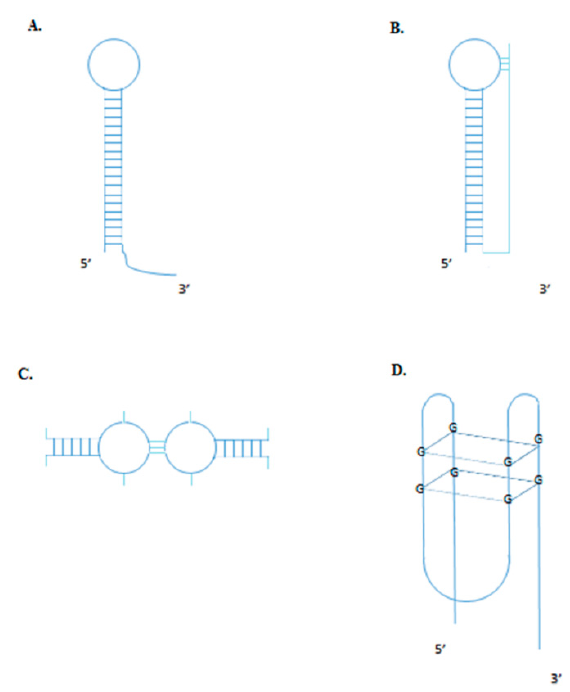
Figure 2. Aptamer secondary structures: ( A ) Hairpin motif; ( B ) Pseudoknot motif; ( C ) “Kissing loops” motif; and ( D ) G-quadruplex chair folding structure.